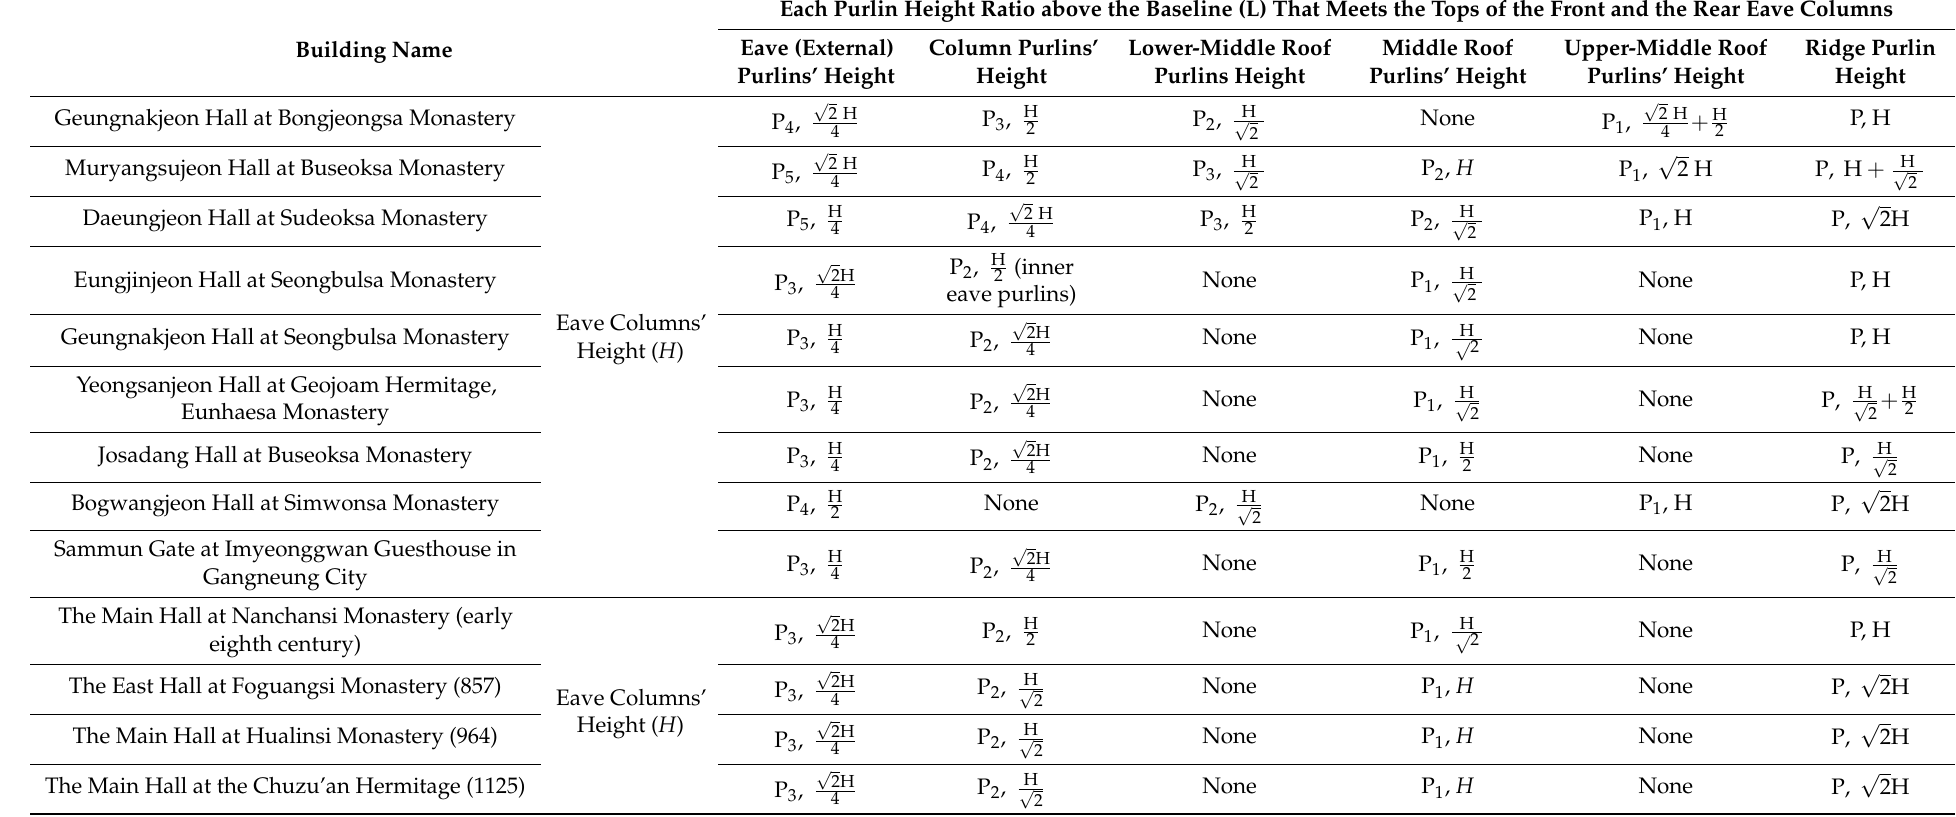
√ 2 times the height of eave columns above the baseline